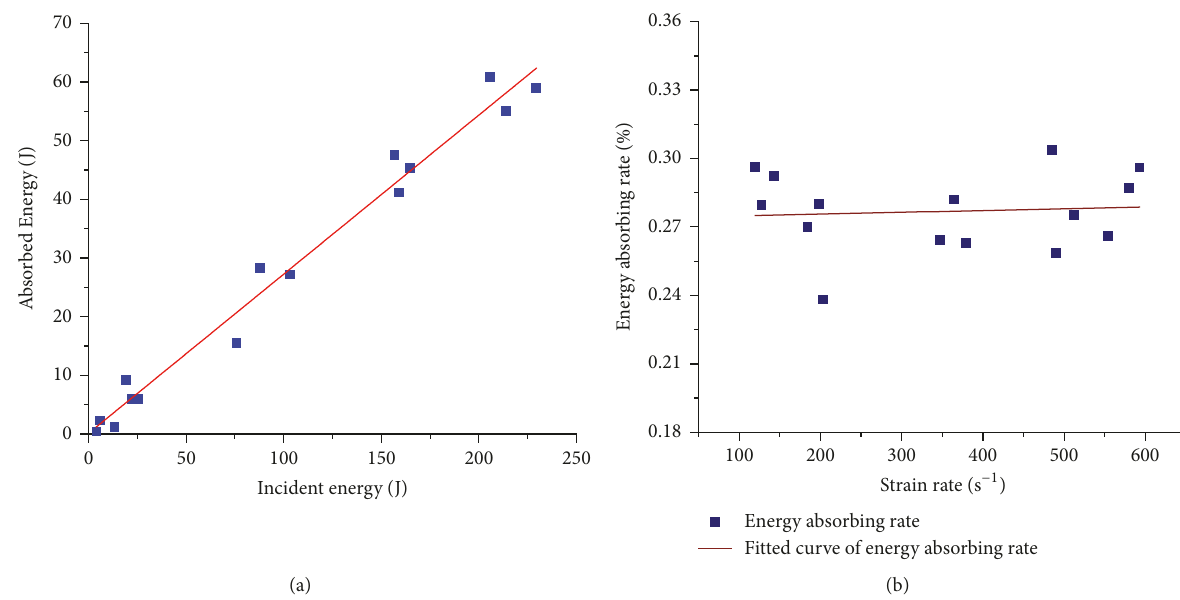
Figure 8: Relationship between the absorbed energy and incident energy and the energy-absorbing rate.